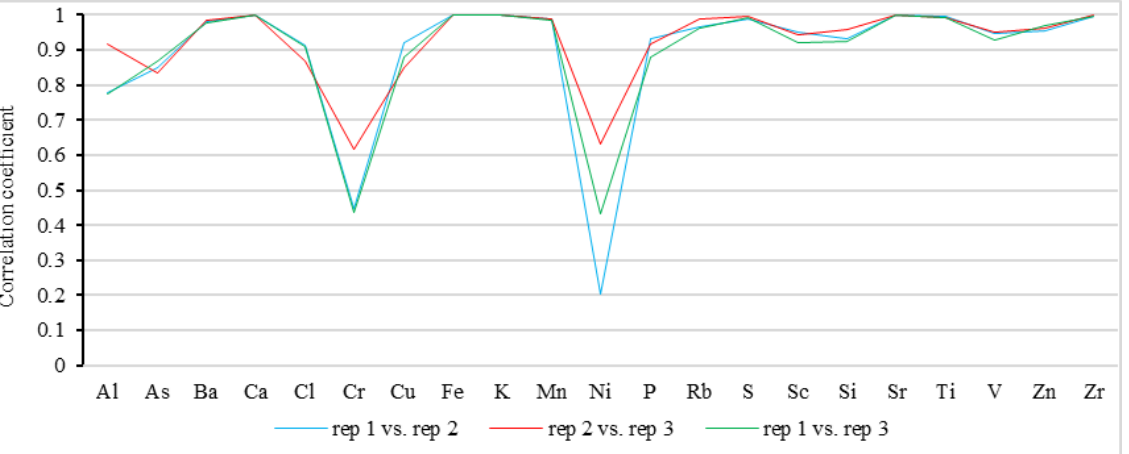
Figure 6. Correlation between different repeated measurements of rock powder samples by pXRF.